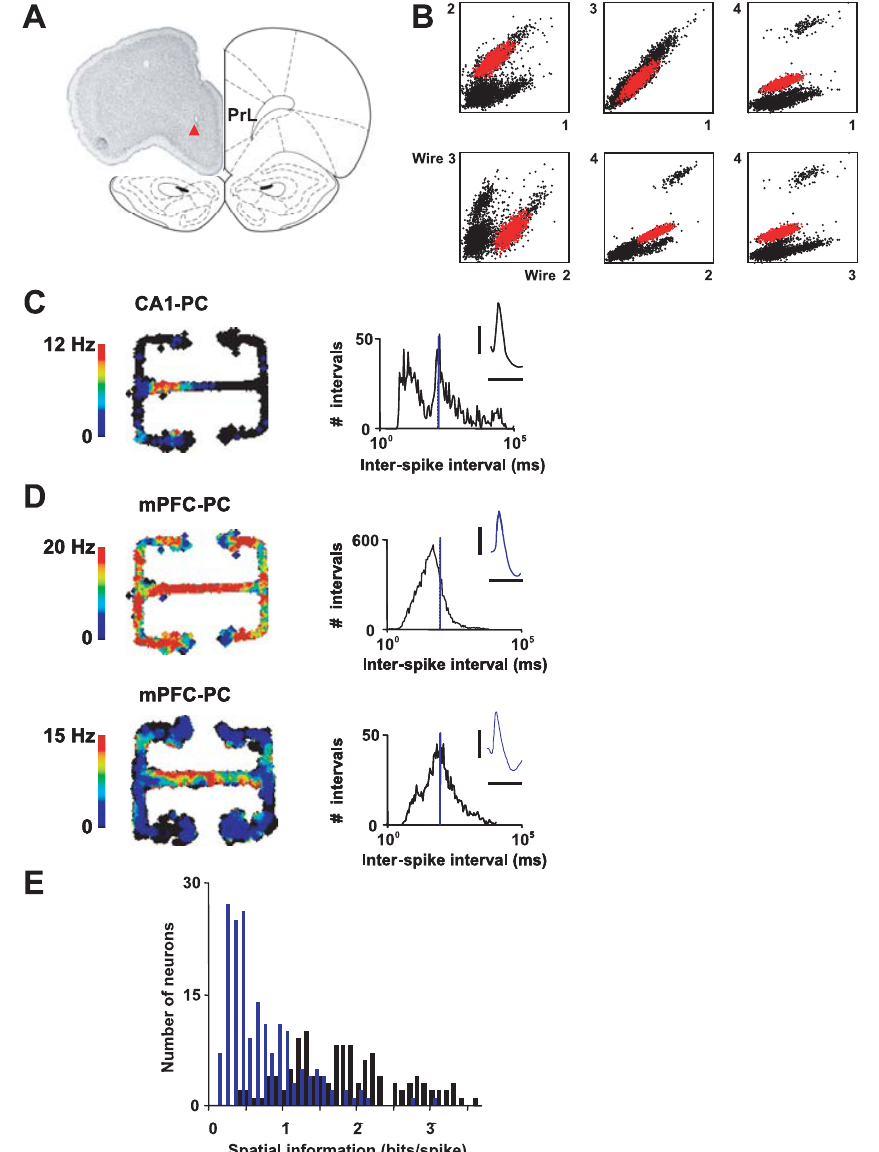
Figure 2. Recording Details and Typical Hippocampal and Prefrontal Firing Properties on the Maze (A) mPFC tetrodes targeted deep layers of prelimbic and infralimbic cortices. Photograph shows a typical lesion site (triangle) marking the tip of a tetrode. The partial brain section is superimposed on a schematic of a coronal section taken 3.7 mm rostral of bregma, showing the boundary of the prelimbic cortex (denoted by PrL). (B) Spike amplitude clusters for a typical mPFC tetrode. The cluster in red was for the neuron shown in D. The points in the six panels plot extracellular- action-potential amplitude on wire 1 of the tetrode versus wire 2, wire 1 versus wire 3, etc. (C) and (D) Activities of a typical CA1 place cell and two mPFC pyramidal cells, respectively (see also Figure S2). The upper mPFC neuron in D was recorded simultaneously with the CA1 neuron in C. Spikes were binned into positional pixels, and mean pixel firing rate was color-coded to generate the firing-rate maps on the left. Graphs show corresponding inter-spike interval distributions (10 Hz marked by the blue line; note logarithmic time scale). Waveforms show averaged extracellular action potentials recorded on a single wire of each tetrode (horizontal and vertical scale bars, 1 ms and 400 l V, respectively). (E) Overlap in the distributions of spatial information carried by spikes from CA1 (black) and mPFC (blue) populations. DOI: 10.1371/journal.pbio.0030402.g002